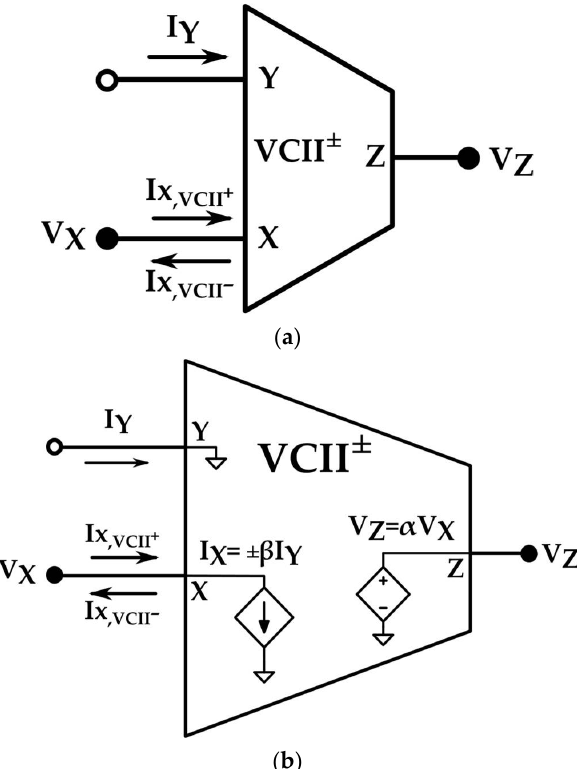
Figure 1. ( a ) Symbolic representation and ( b ) internal structure [27].